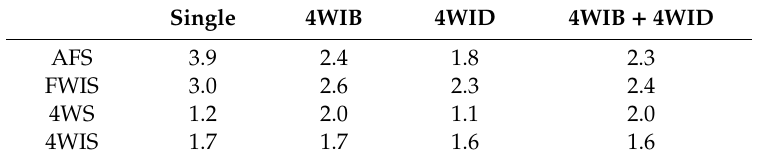
Table 2. Maximum absolute yaw rate errors for each actuator combination (degrees / s).